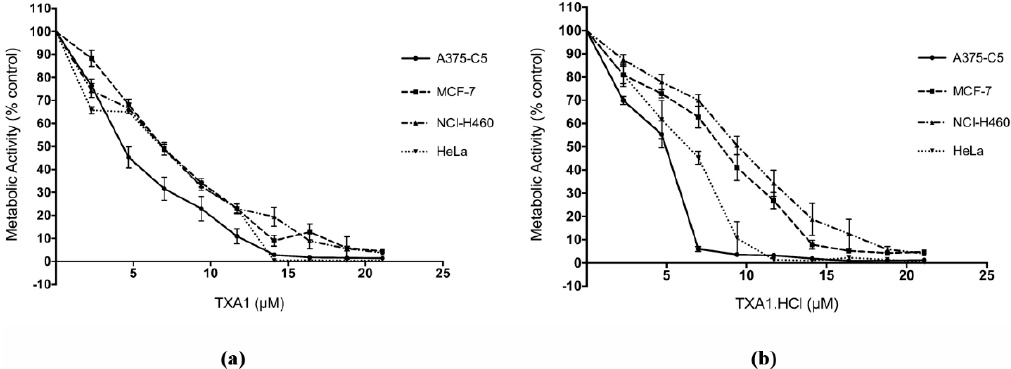
Figure 1. Effect of TXA1 ( a ) and TXA1·HCl ( b ) in four human tumor cell lines, analyzed with the MTT assay. Cells (A375-C5, MCF-7, NCI-H460 and HeLa) were continuously treated with TXA1 or